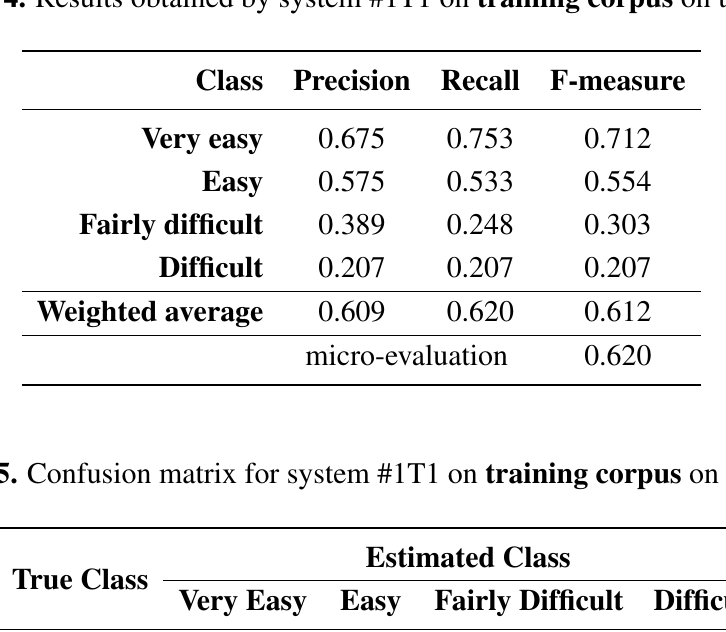
Table 4. Results obtained by system #1T1 on training corpus on task 1.